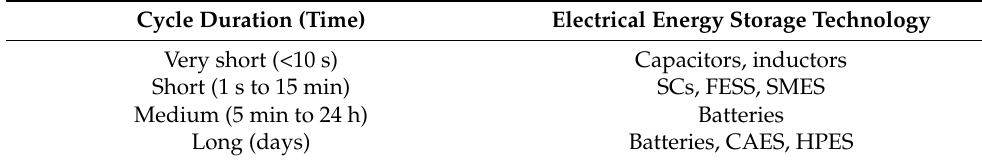
Table 2. Classification of the ESSs based on their cycle duration (based on